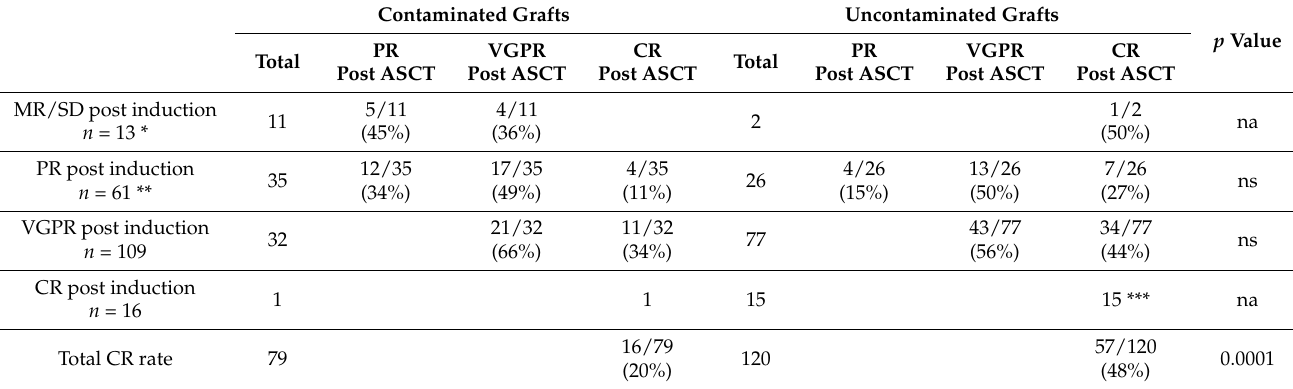
Table 2. Response improvement post ASCT according to stem cell graft contamination